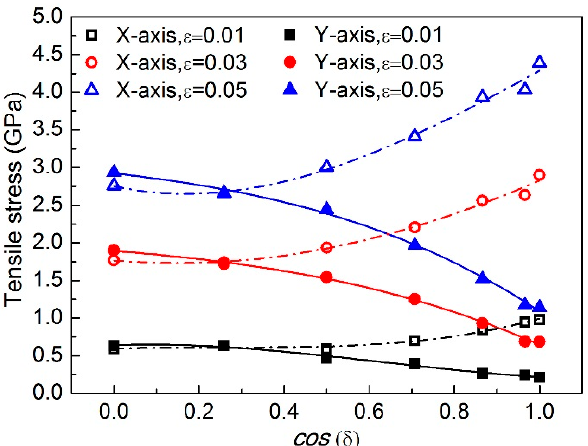
Figure 5. Evolution of tensile stress at selected strain levels during the loading with respect to the stacking angle difference δ .